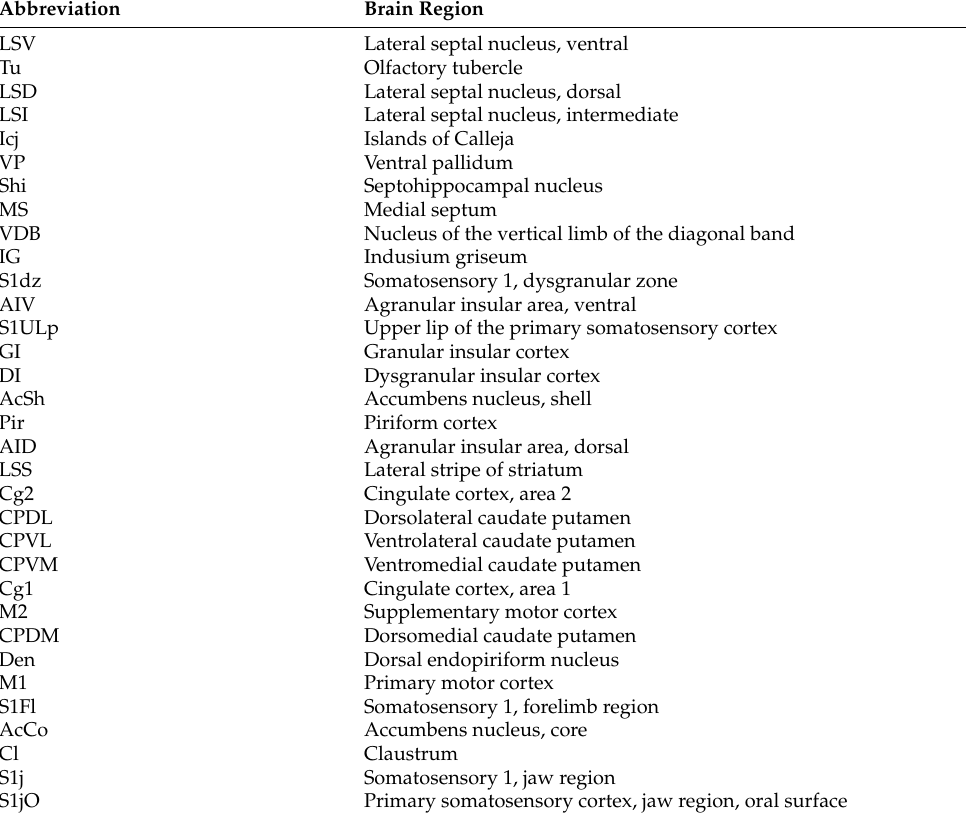
Table 1. Regions of interest (ROIs) we quantitated in the present study and corresponding